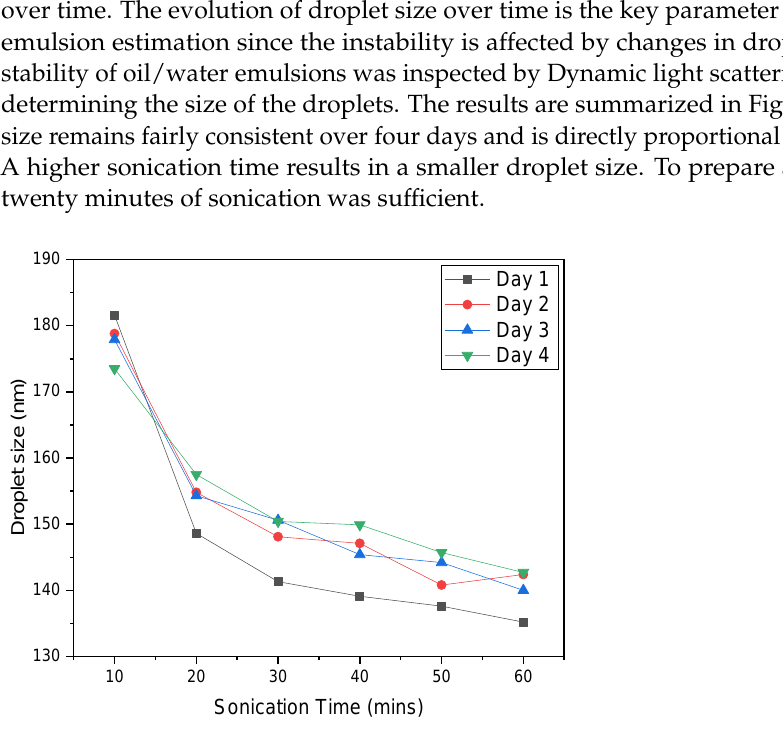
Table 2. Influence of initial oil concentration on the adsorption of emulsified diesel oil (DO) onto 3.0 g treated dosage at a contact time of 24 h.